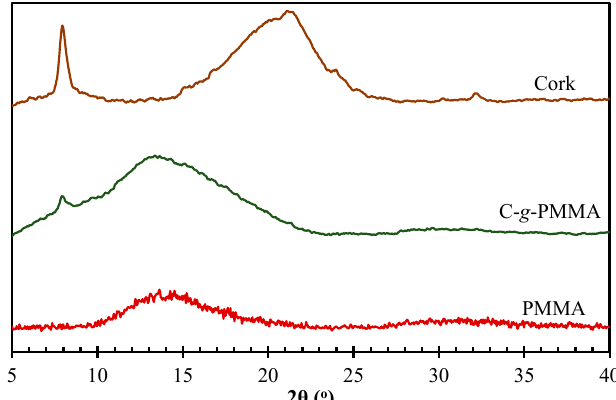
Figure 3. X-ray diffractograms of Cork, C- g -PMMA and PMMA homopolymer (produced via ATRP). Figure 3. X-ray di ff ractograms of Cork, C- g -PMMA and PMMA homopolymer (produced via ATRP).